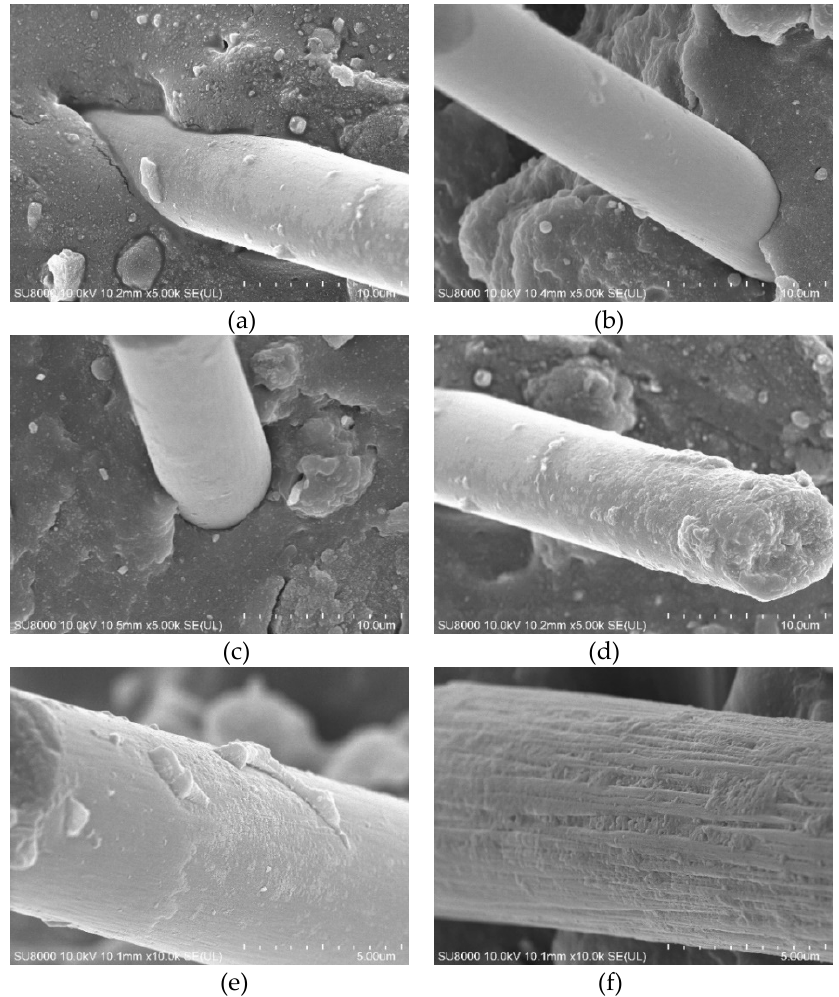
Figure 5. SEM picture of composites of CF modified by different concentration of dopamine. ( a ) The concentration of dopamine was 0 g/L; ( b ) the concentration of dopamine was 0.5 g/L; ( c ) the concentration of dopamine was 1 g/L; ( d ) the concentration of dopamine was 1.5 g/L; ( e ) the concentration of dopamine was 2 g/L; ( f ) the concentration of dopamine was 2.5 g/L.